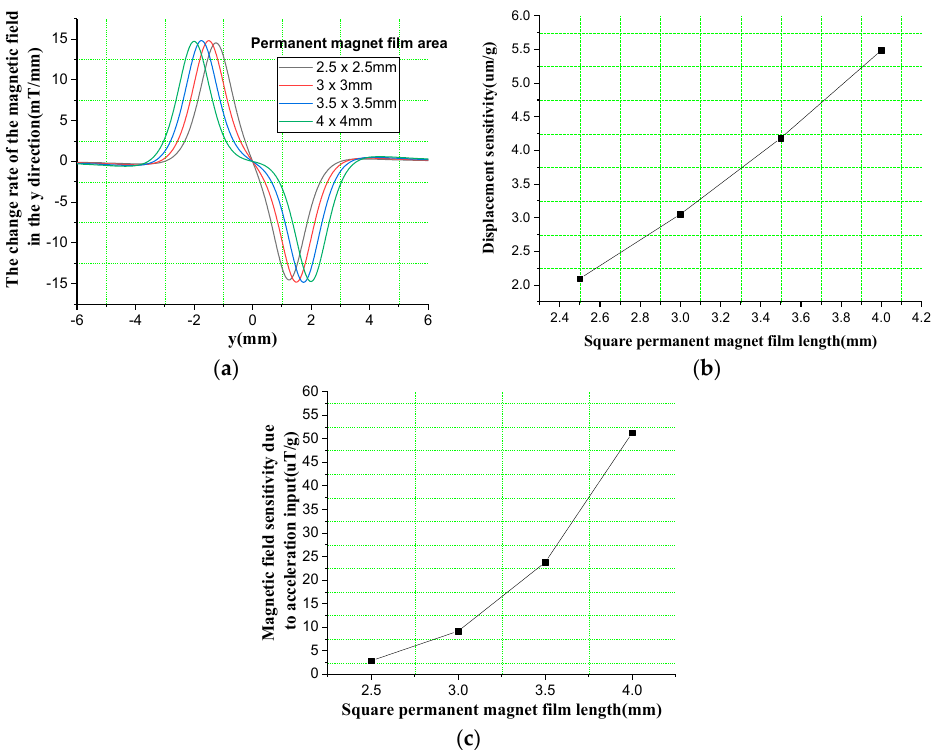
Figure 7. Influence of structure dimension of permanent magnet film on characteristics of the tunneling magnetoresistive accelerometer. ( a ) The change rate of the magnetic field in the y direction due to a displacement variation in the z direction versus different structure dimension of permanent magnet film; ( b ) Mechanical sensitivity versus different structure dimension of permanent magnet film; ( c ) The magnetic field sensitivity in the y direction due to input acceleration in the z direction versus different structure dimension of permanent magnet film (y = 2.5 mm).